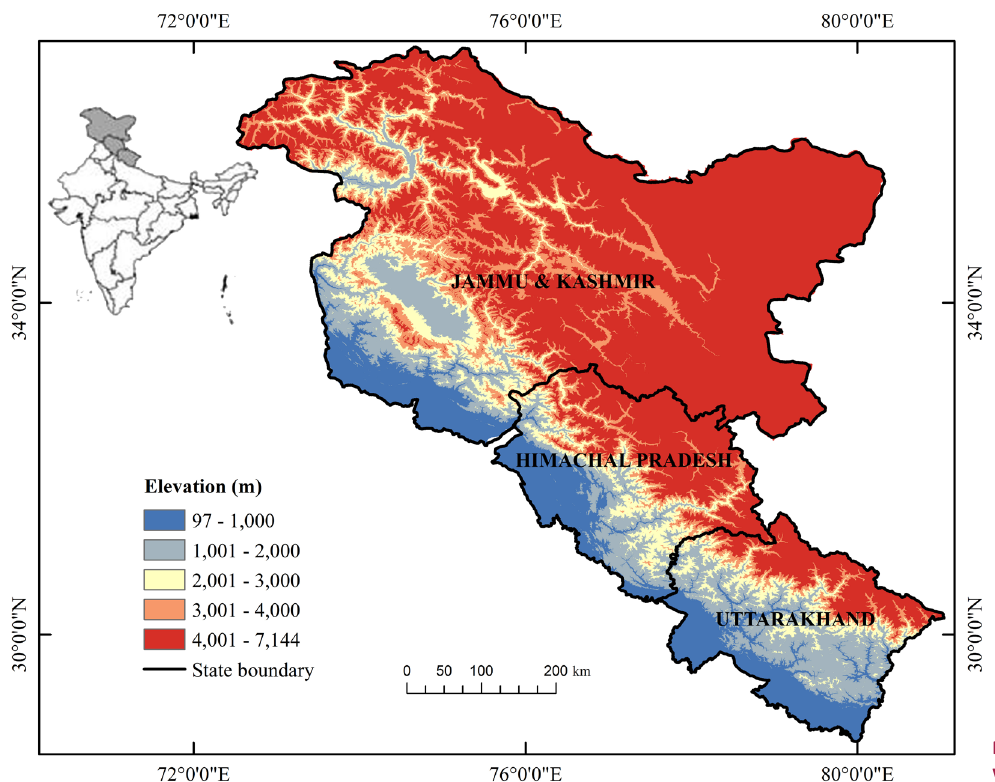
Figure 1. The Indian western